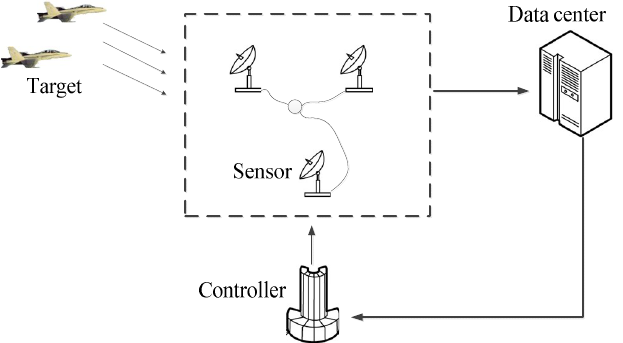
Figure 1. Description of sensor scheduling problem.